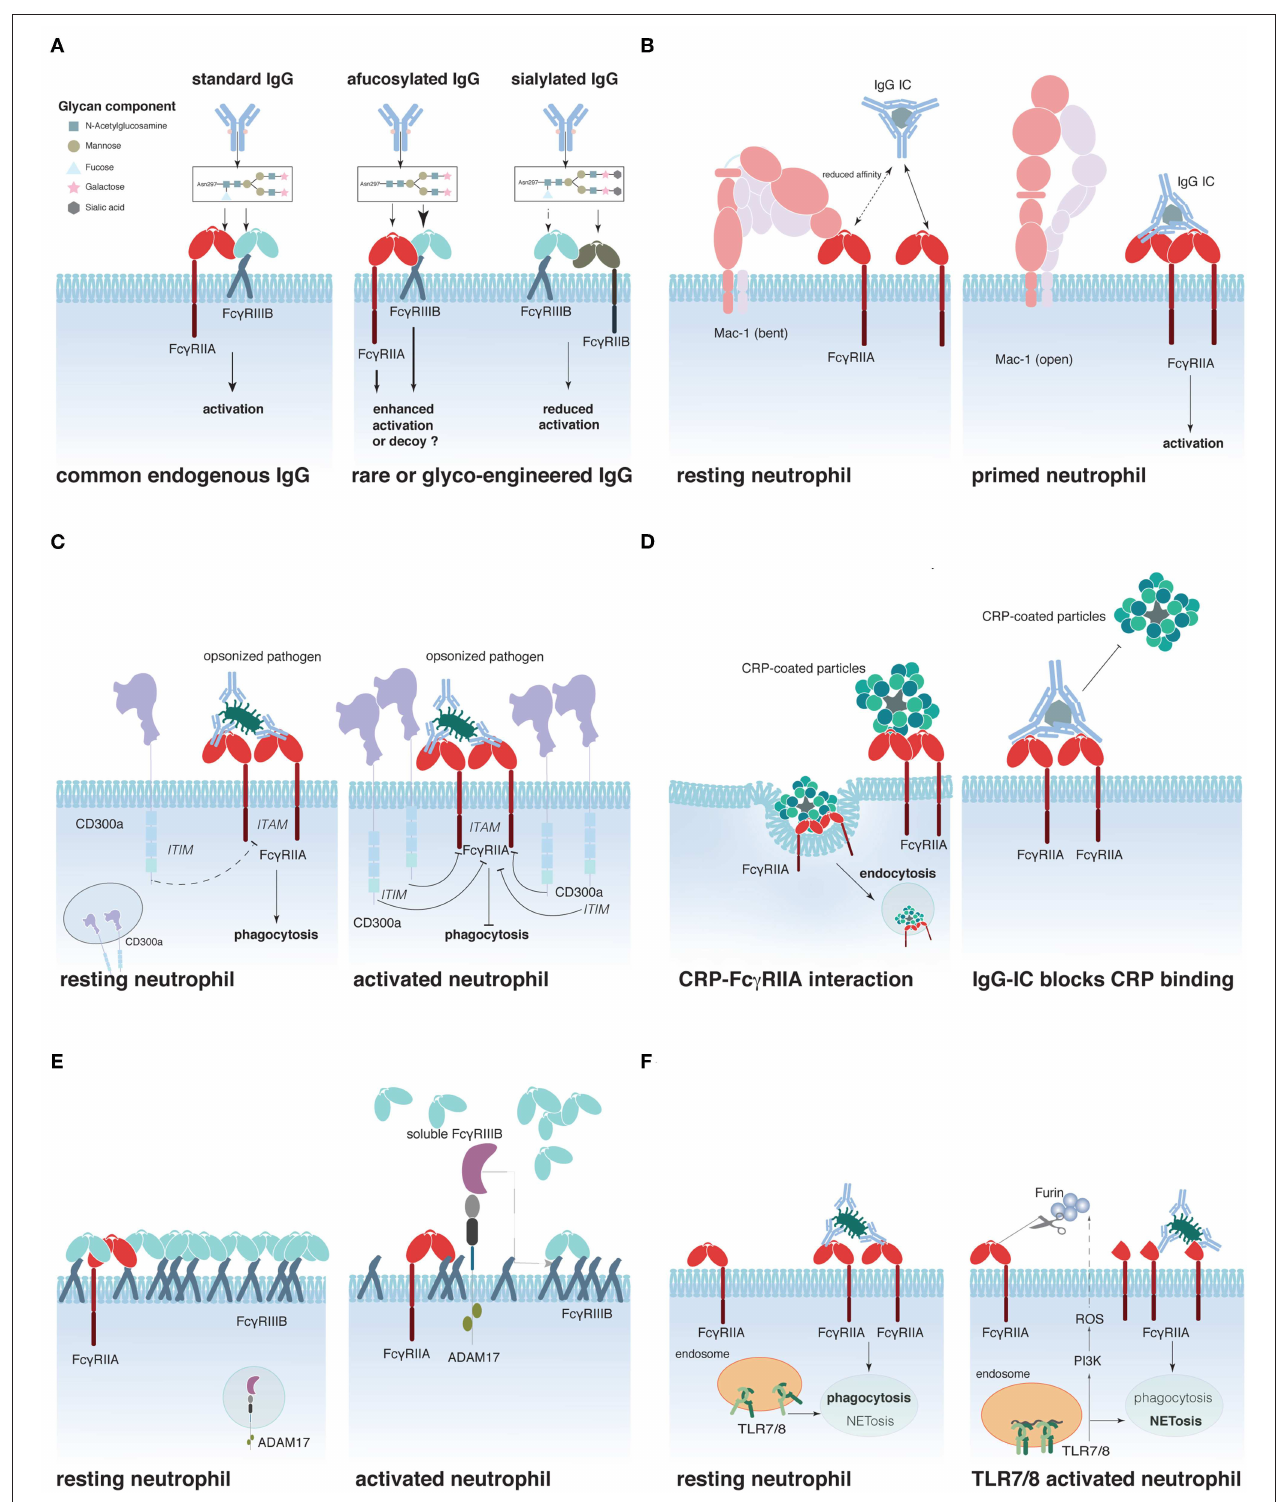
FIGURE 1 | Schematic representation of proposed mechanisms that regulate Fc γ R activity on neutrophils. (A) IgG glycosylation determines its affinity for Fc γ Rs, (B) Mac-1 regulates Fc γ RIIA affinity for IgG, (C) CD300a-mediated Fc γ RIIA inhibition, (D) C-reactive protein (CRP)-driven Fc γ RIIA down-regulation, (E) Fc γ RIIIB shedding by ADAM17, and (F) Interplay between Toll-like receptors (TLR)7/8 and Fc γ RIIA.